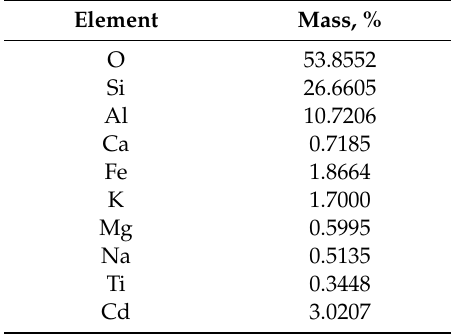
Table 2. Elemental composition of FA / H 2 SO 4 + Cd 2 +